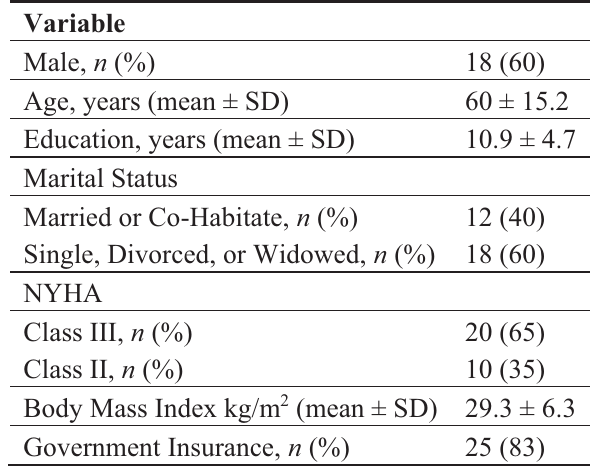
Table 1. Clinical characteristics of the study participants ( n =